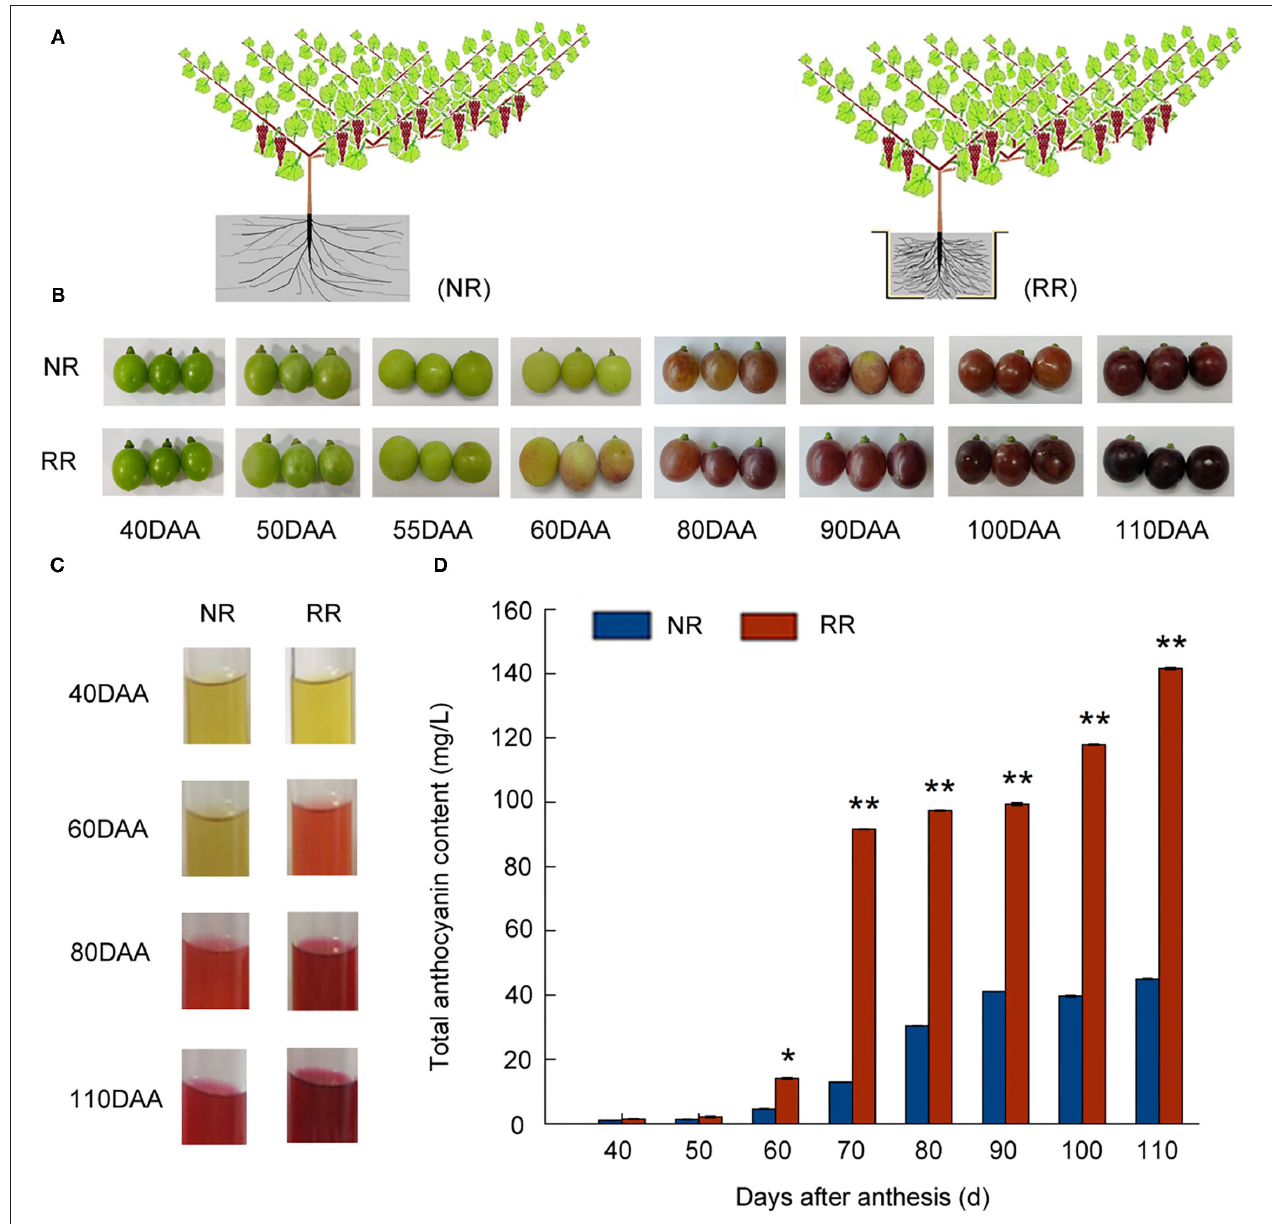
FIGURE 1 | Effects of root restriction cultivation on fruit development and anthocyanin accumulation during grape berry development: (A) Model of root restriction (RR) and no root restriction cultivation (NR, control); (B) process of berry development in grape berries under root restriction cultivation (RR) and no restriction cultivation (NR, control); (C) anthocyanin staining; and (D) relative anthocyanin contents of grape berries under root restriction (RR) and no root restriction (NR) cultivation. Three biological replicates were performed. Lines graphs and error bars represent average and SE, respectively. Asterisks represent different level of significance ( P ≤ 0.05*, P ≤ 0.01**), and significant differences are indicted by different lowercase letters based on independent sample t -test.